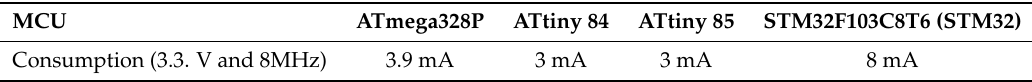
Table 2. Comparison of microcontroller (MCU) consumption that support LoRaWAN communication. MCU